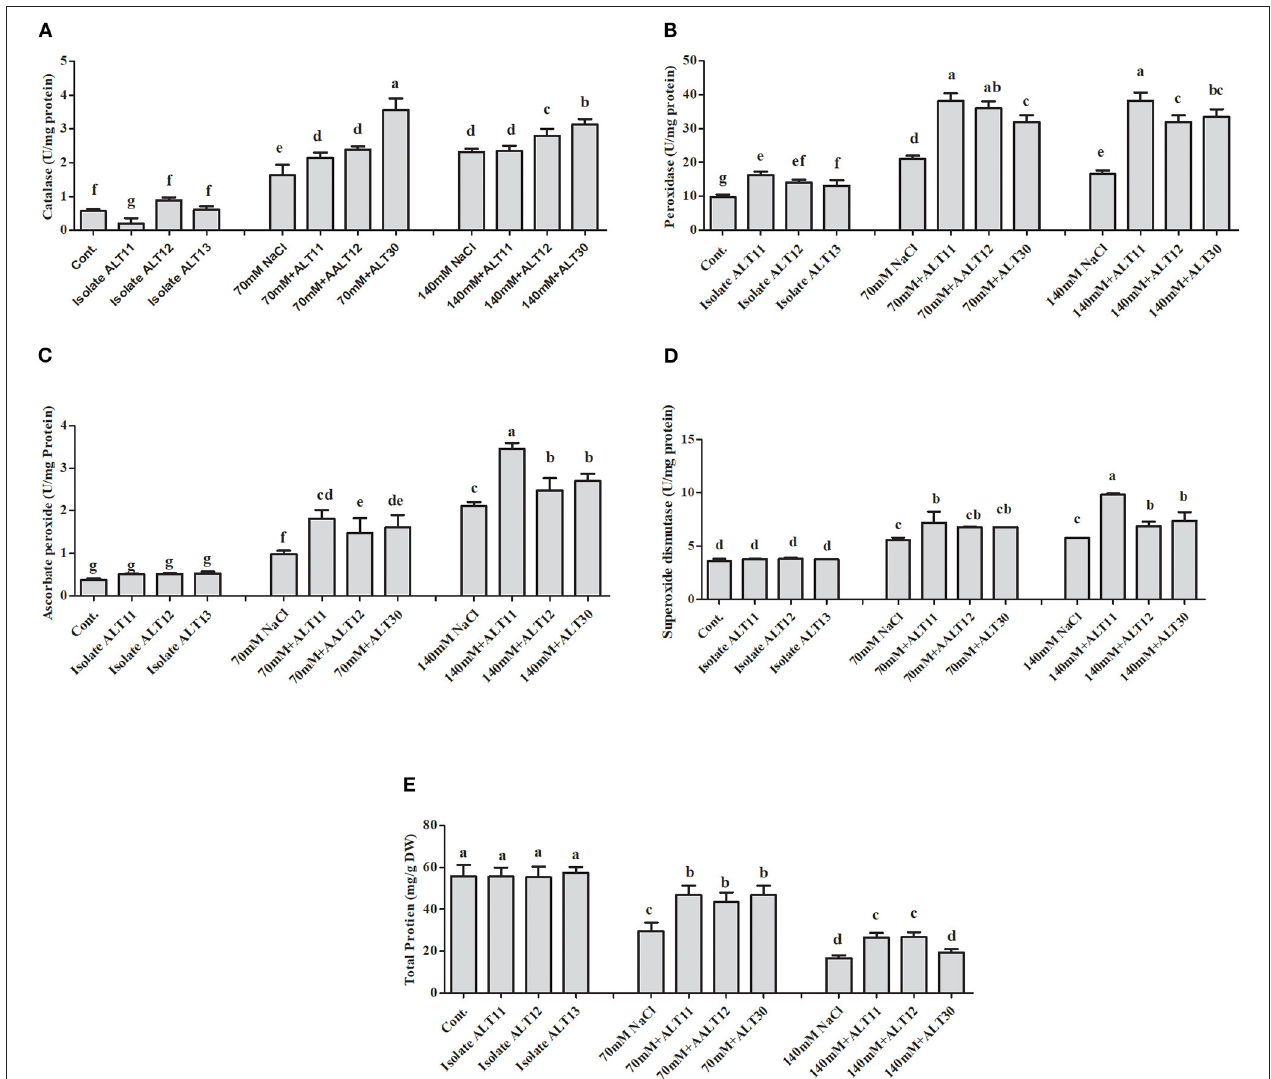
FIGURE 5 | The effect of isolates ALT11, ALT12, and ALT30 on different antioxidants under normal conditions and NaCl stress (70 and 140mM). (A) Catalase (CAT); (B) peroxidase (POD); (C) ascorbic peroxidase (APX); (D) superoxide dismutase (SOD); and (E) total protein (TP). Different letters indicate significant differences between the mean values of three replicates ± standard